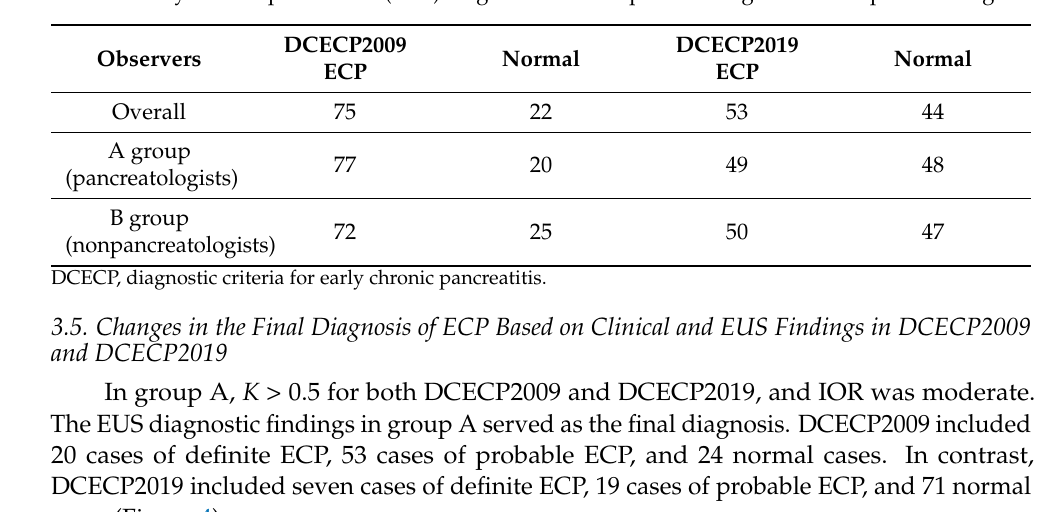
Table 5. Early chronic pancreatitis (ECP) diagnosis between pancreatologists and nonpancreatologists.